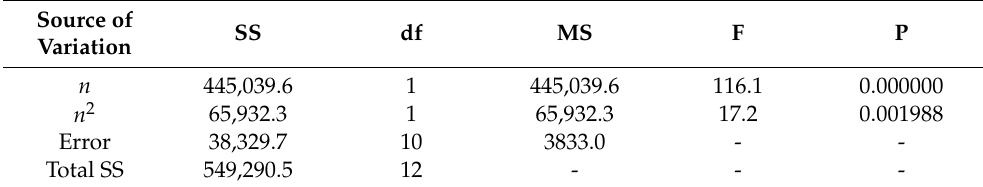
Table 5. Model of specific energy consumption of the extruder E jc —ANOVA table. R 2 = 0.93; R adj2 = 0.92.